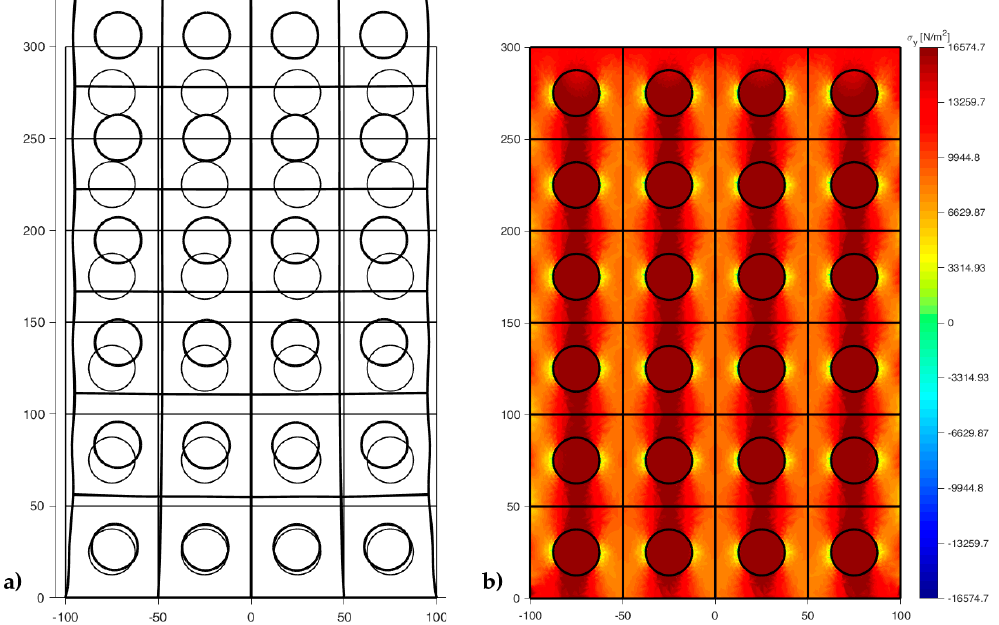
Figure 33. Elastic modeling of the 6 × 4 array subjected to uniaxial traction: ( a ) Deformed configuration (amplification factor of the displacements: k = 400 ) and ( b ) normal stresses σ y .